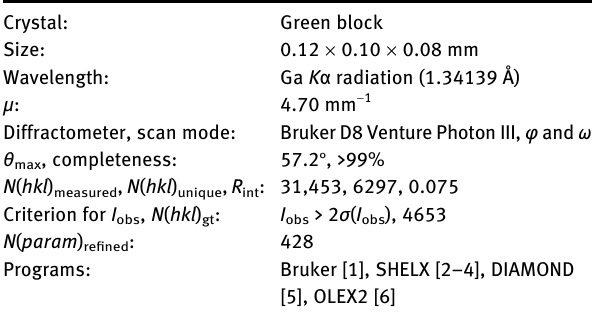
Table  : Data collection and